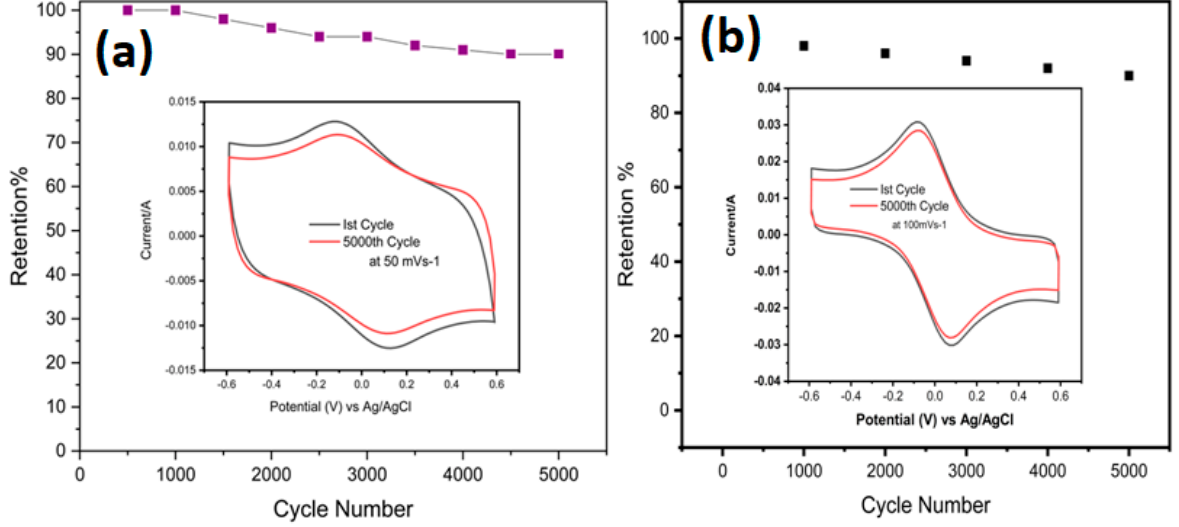
Figure 8. ( a ) Symmetric SC MXene showing good cyclic stability at 50 mVs − 1 in 1 M H 2 SO 4 after 5000 cycles; ( b ) Symmetric SC MX/AuNPs showing good cyclic stability at 100 mVs − 1 in 3 M H 2 SO 4 after 5000 cycles.